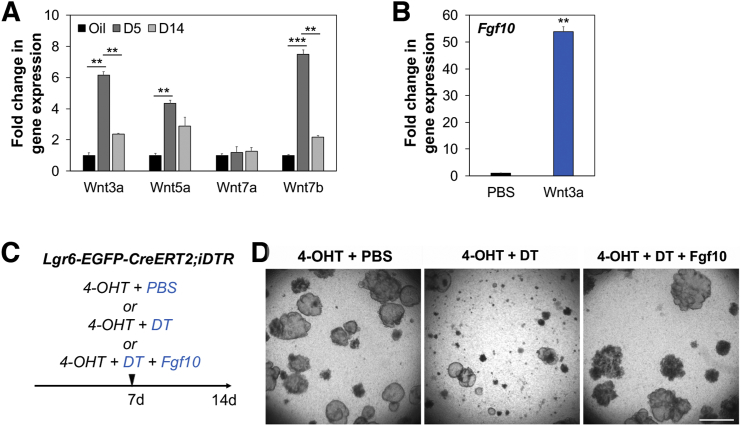
Lgr6+ Cells Produce Fgf10, which Acts on Proliferation and Differentiation of Scgb1a1+ Cells in In Vitro Organoid Formation, Related to Figure 6(A) qPCR analysis for the expression of Wnt ligands in freshly isolated Scgb1a1+ cells from lung tissues of vehicle-treated and naphthalene-treated mice. Data presented are the mean of experiments from three individual mice per group. Error bars indicate standard deviation (∗∗p < 0.005; ∗∗∗p < 0.001).(B) qPCR analysis for the expression of Fgf10 in cultured Lgr6+ cells with addition of PBS (black bar) and Wnt3a (blue bar). Normalized to Gapdh. Data presented are the mean of three independent experiments with triplicates. Error bars indicate standard deviation (∗∗p < 0.005).(C) Experimental scheme of depleting Lgr6-expressing cells in co-culture of Scgb1a1+ cells. Lgr6-CreERT2;R26-iDTR mice are utilized to isolate Lgr6-expressing cells following by co-culture with Scgb1a1+ cells. 4-OHT is added for inducing expression of DTR in Lgr6+ cells and DT is treated for ablation of these cells at day 7 in cultures with or without Fgf10.(D) Representative phase-contrast images of lung organoids with addition of DT and Fgf10 at day 7 in cultures. Scale bar, 500um.